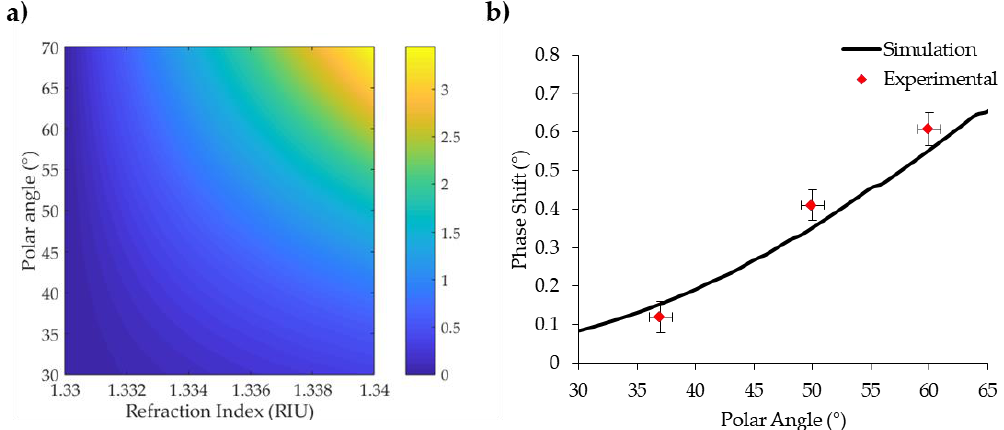
Figure 3. Numerical simulations and experimental results of polar contribution to phase shift enhancement. ( a ) Phase shift colour map of gold gratings with a 400 nm period in water, varying the polar angle in resonance condition. Incident wavelength: 633 nm. ( b ) Experimental phase shift enhancement with polar incidence angle. Red dots represent experimental data; the black line is the simulated value for the corresponding refraction index shift extrapolated from the colour map. s.e.m. of the points are shown.